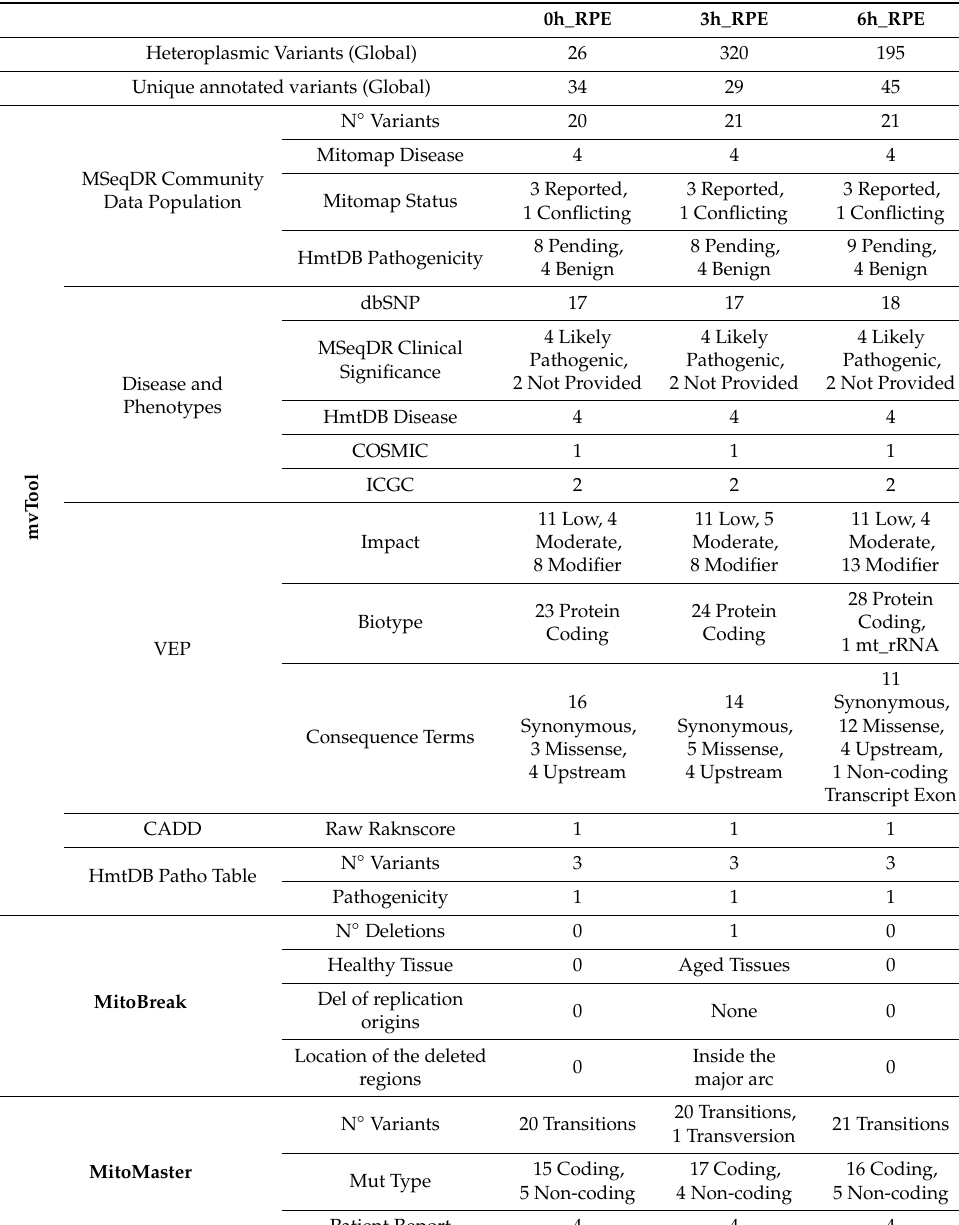
Table 2. RNA-Seq sample variant annotation summary. Table reports a summary of detected variants, together with key mitogenome variant annotations from examined databases by mvTool, MitoBreak and